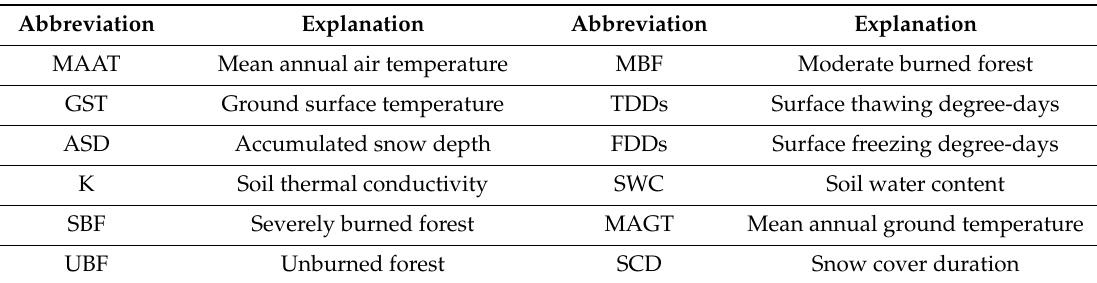
Table 1. List of abbreviations used in the